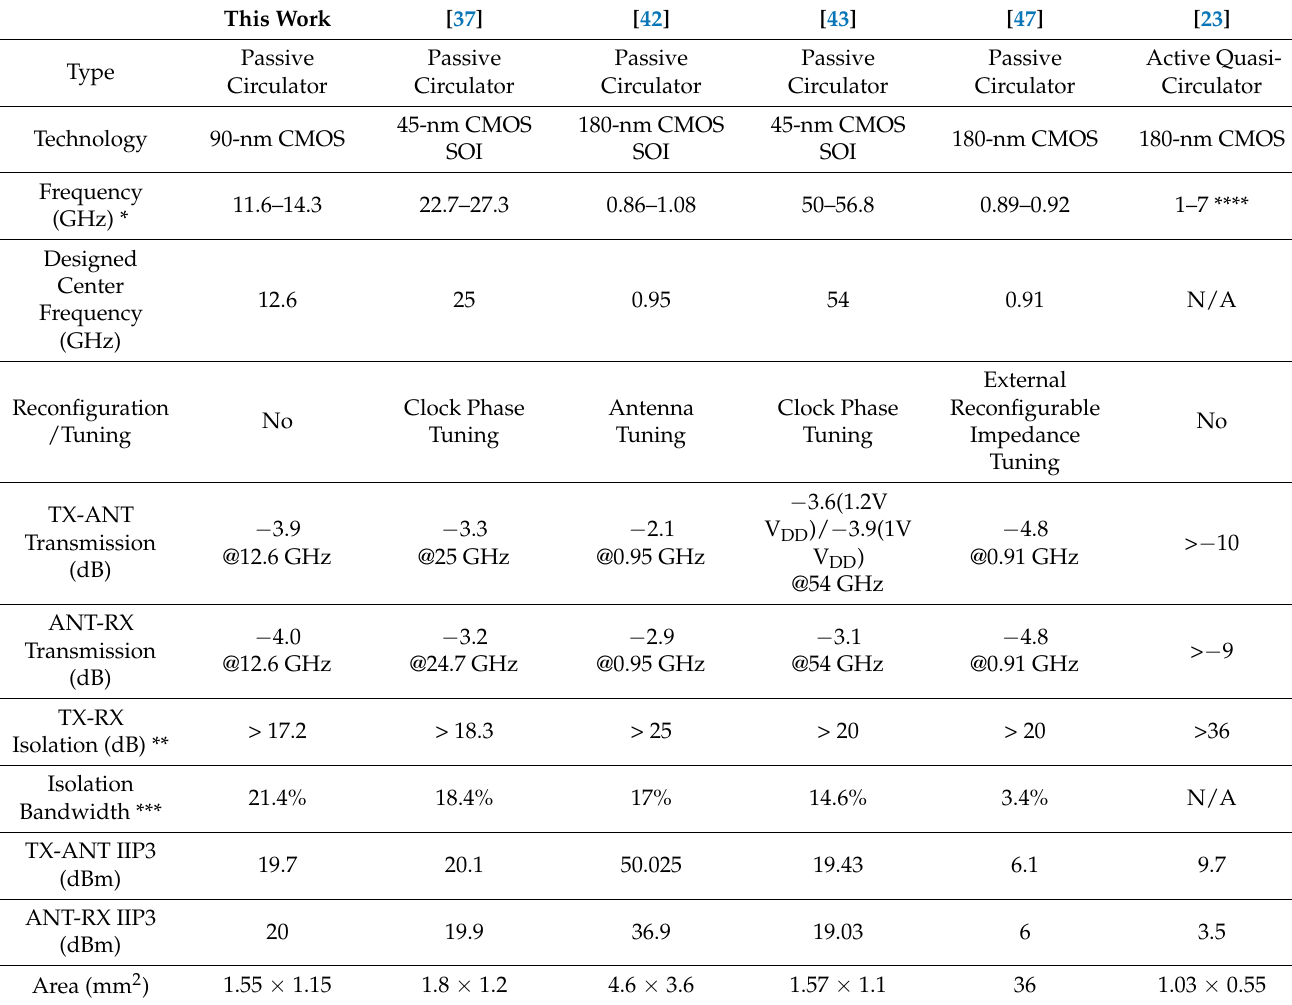
Table 4. Comparison table with the